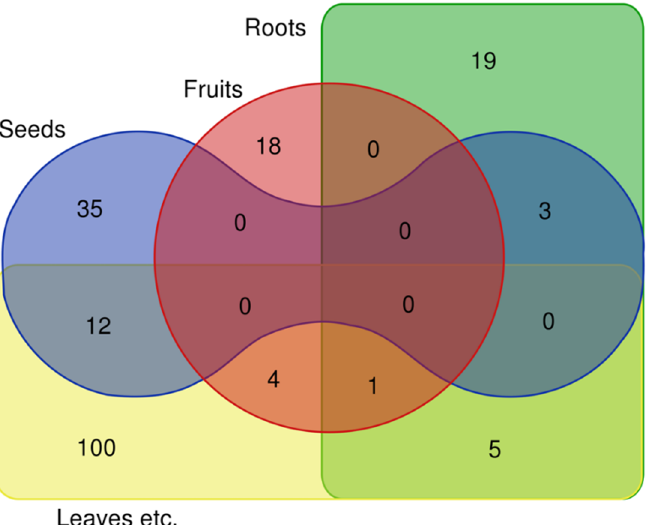
Figure 4. Venn diagram of the parts used of 197 certain species (the omitted species, Sambucus nigra , is the only one mentioned only for flowers and was not included in the diagram).